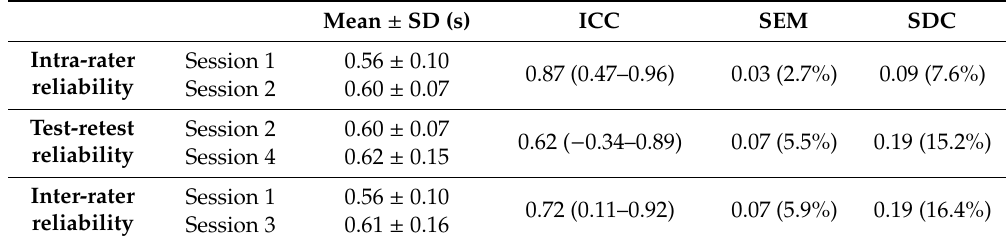
Table 7. Results for gait step